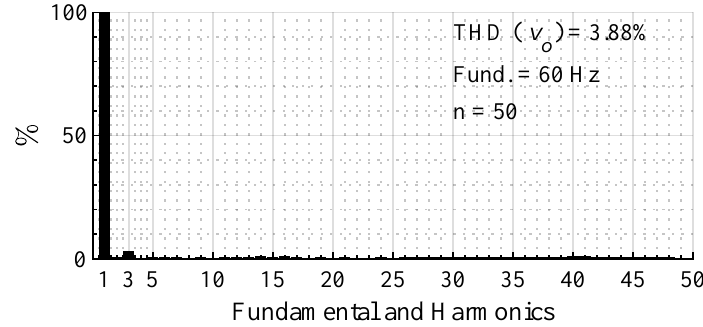
Figure 30. Measurement of harmonics and